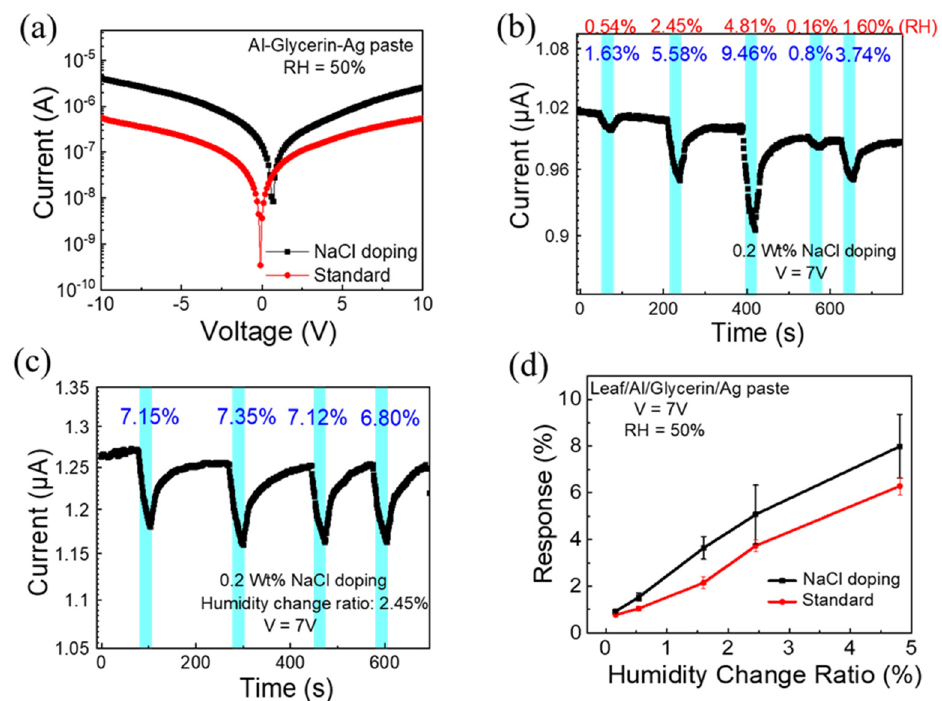
Figure 5. Comparison of device performances with and without NaCl doping. ( a ) I–V curve. ( b ) Real-time current at low humidity levels. ( c ) Repeatability test of the device with the NaCl doping sensing layer. ( d ) Sensing response of both devices at low humidity conditions.